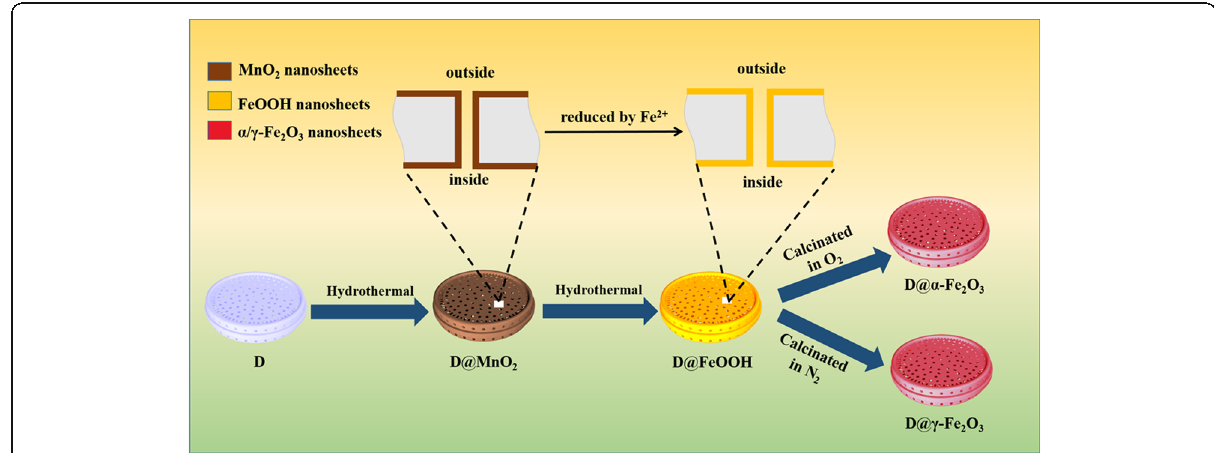
Fig. 1 Preparative route of ferric oxides/hydroxides-based